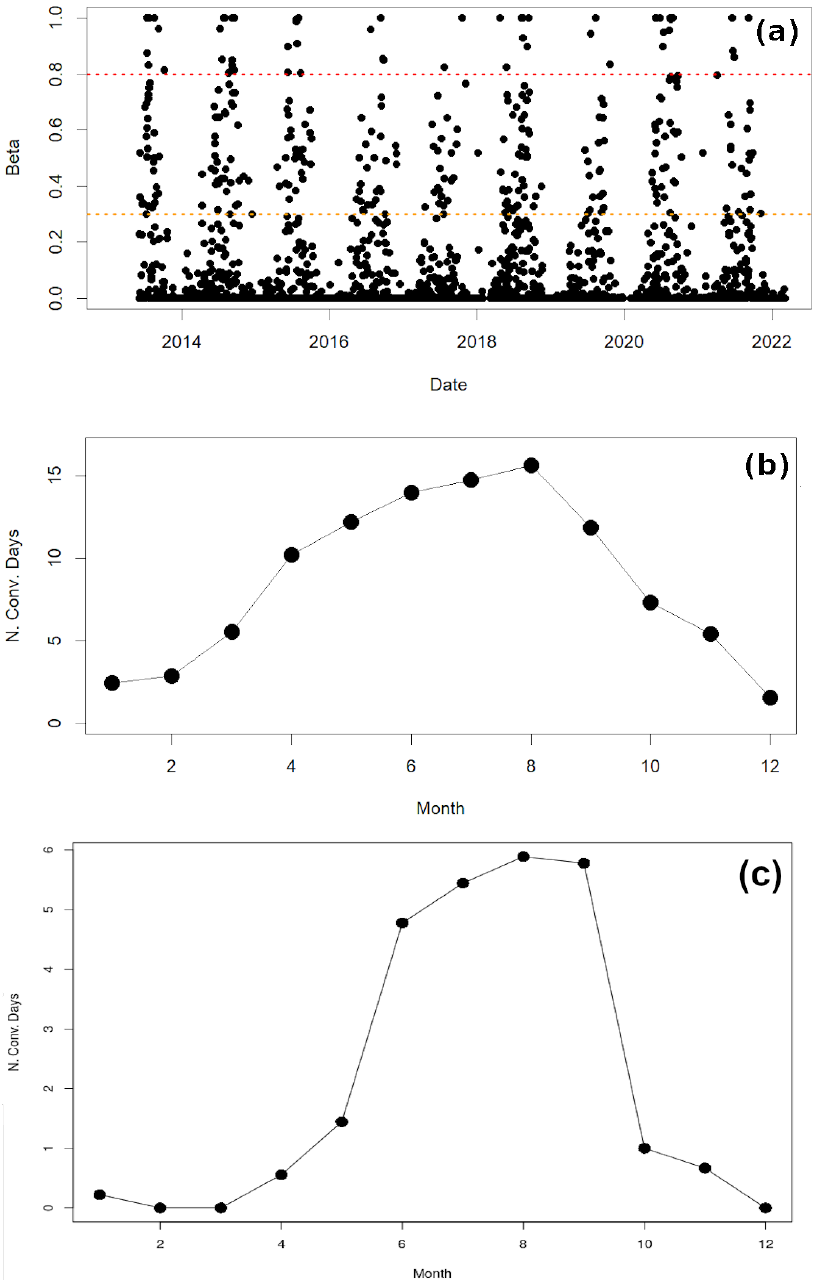
Figure 4. ( a ) Daily evolution of the beta parameter estimated with radar and lightning data for the period 2013–2021. Yellow and red horizontal dotted lines indicate the thresholds for the different types of convective regime (slightly, moderately, and strongly convection). ( b ) Monthly distribution of moderately and strongly convective days ( β 0.3). ( c ) The same as ( b ) only for strongly convective